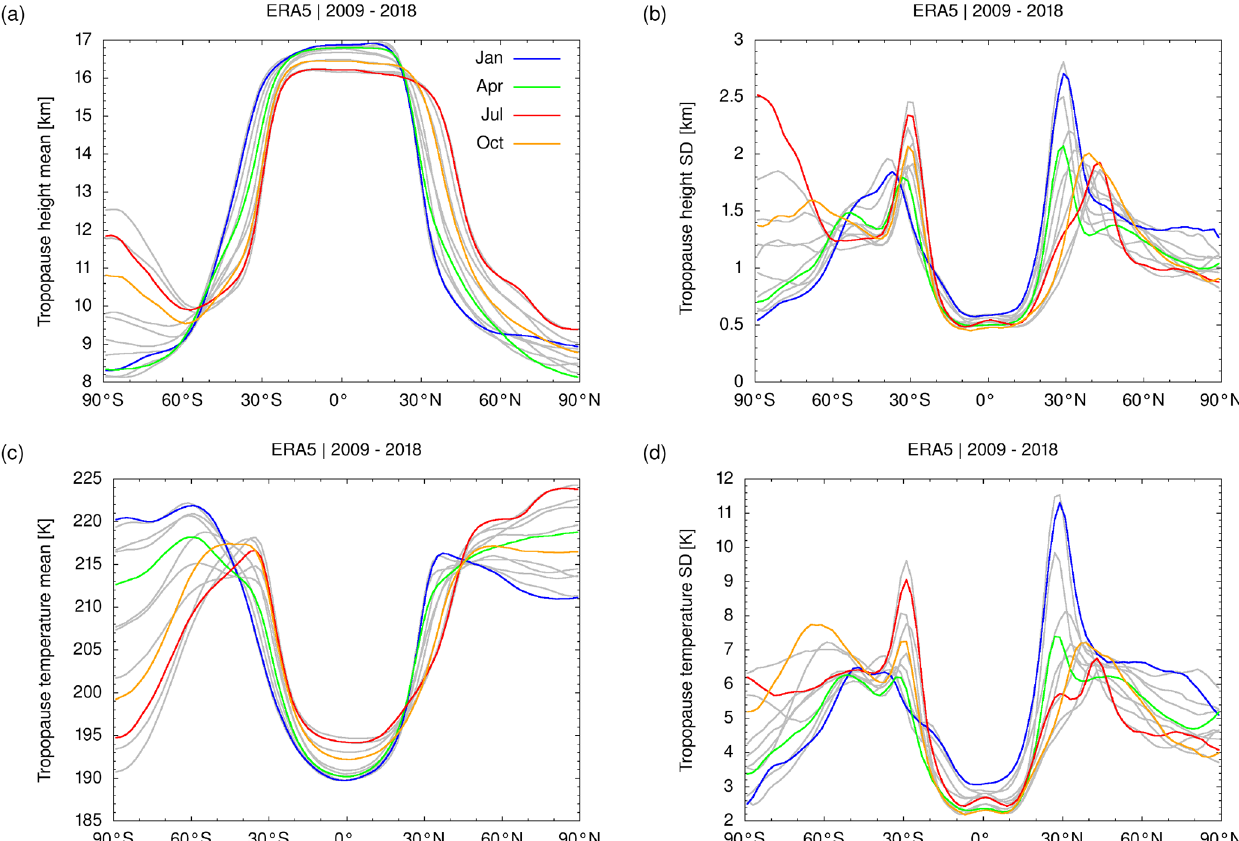
Figure 5. Monthly mean zonal means (a, c) and standard deviations (b, d) of WMO first tropopause geopotential height (a, b) and tempera- ture (c, d) based on ERA5. The months of January, April, July, and October are highlighted (see plot key). Gray curves show data for other months. The statistics presented here were calculated for 2 ◦ latitude bins from 120 million equally distributed random samples of the ERA5 reanalysis data covering the time period from January 2009 to December